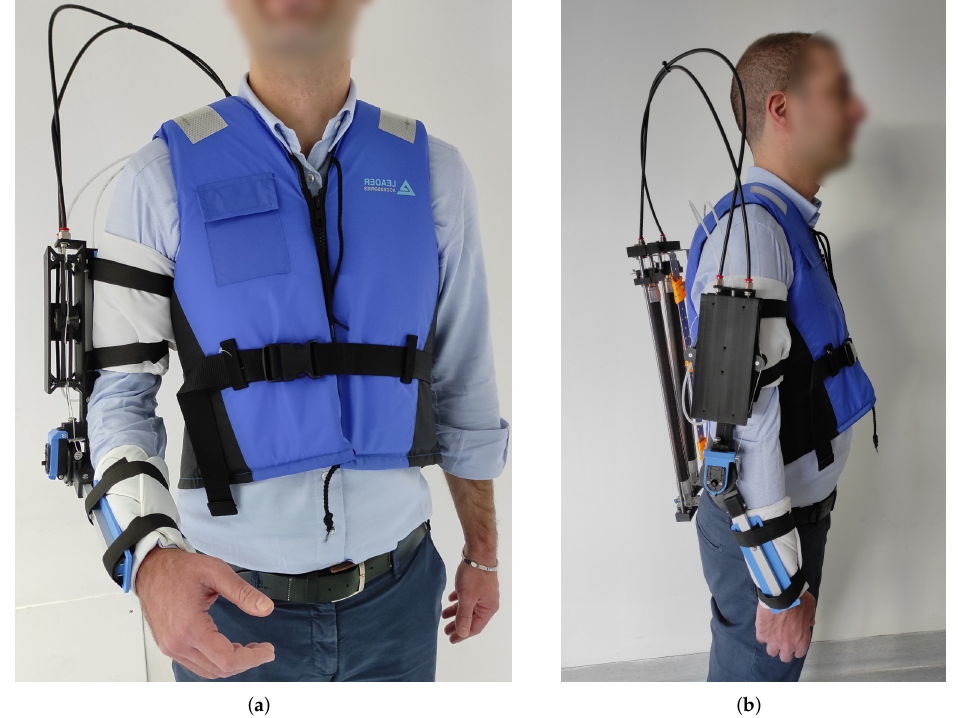
Figure 2. Real exoskeleton: frontal ( a ) and lateral ( b ) view. Some tests on the robot prototype and its PAMs-based actuation (including evaluations on ergonomics, user comfort and wearability of the rehabilitation exoskeletons) were carried out. The antagonistic arrangement of the PAMs pair, through some Bowden cables connecting the actuators and a pulley on the rotational joint, allows the bidirectional and smooth assistance of the rotation (flexion/extension) of the patient’s elbow (see Figure